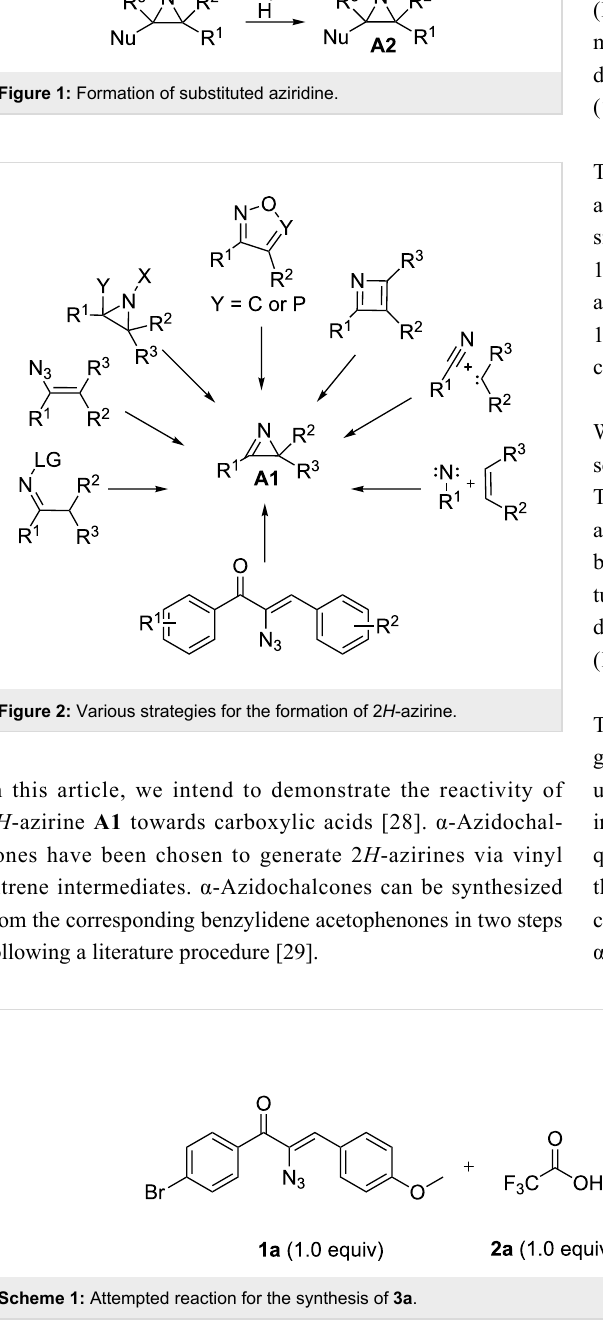
Scheme 1: Attempted reaction for the synthesis of 3a .